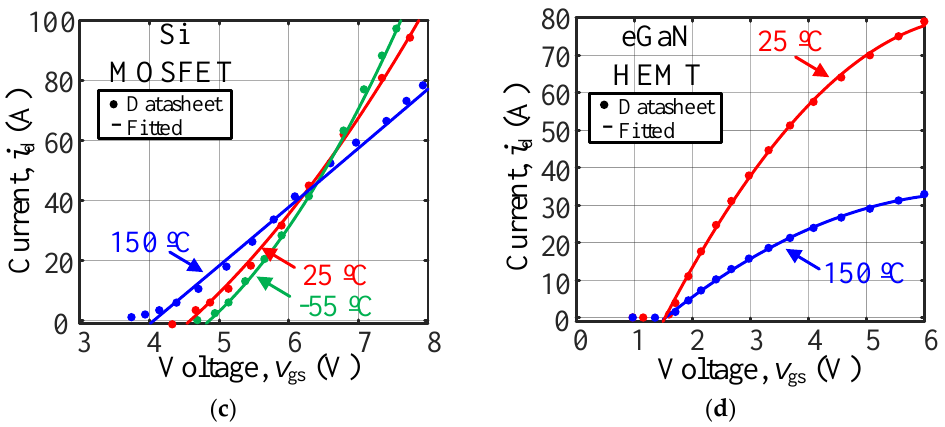
Figure 6. Fitted results of transfer curves for ( a ) Si IGBT; ( b ) SiC MOSFET; ( c ) Si MOSFET; ( d ) eGaN HEMT.